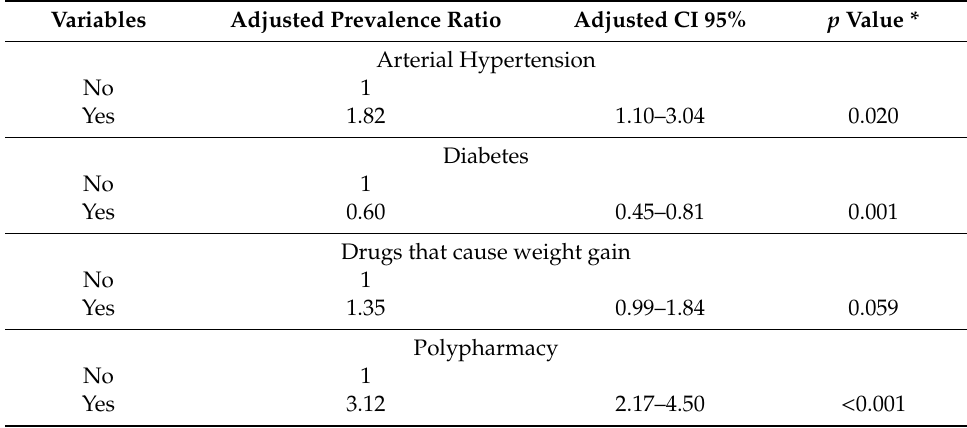
Table 4. Multivariate analysis by Poisson Regression.